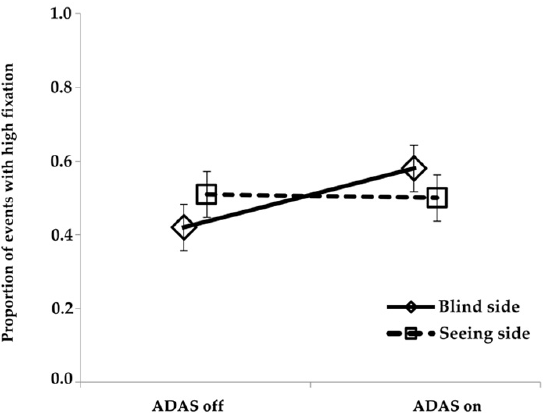
Figure 7. Proportion of high fixation events for HVFD participants in the interaction phase relative